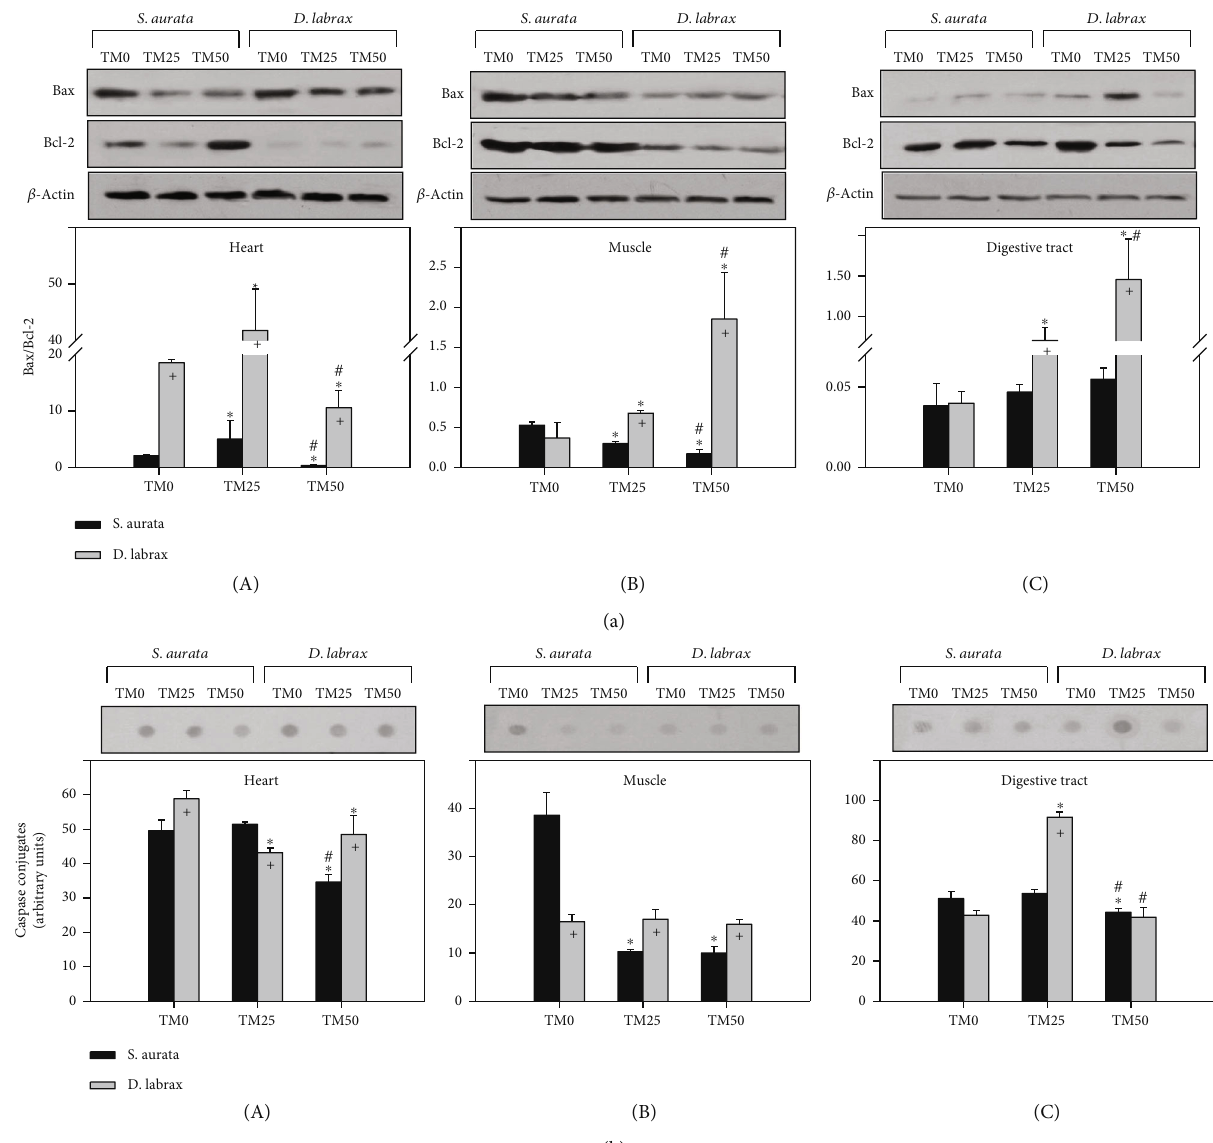
Figure 3: Bax/Bcl-2 ratio (a) and caspase conjugates (b) in the heart (A), muscle (B), and digestive tract (C) of gilthead sea bream ( S. aurata ) and European sea bass ( D. labrax ) under the 0% (TM0), 25% (TM25), and 50% (TM50) T. molitor inclusion diet treatment. Representative immunoblots are shown and were quanti fi ed by laser scanning densitometry and plotted. Values represent means ± SD ; n = 5 preparations from di ff erent animals. ∗ indicates p < 0 : 05 compared with 0%, # indicates p < 0 : 05 compared with 25%, and + indicates p < 0 : 05 between species at the same TM